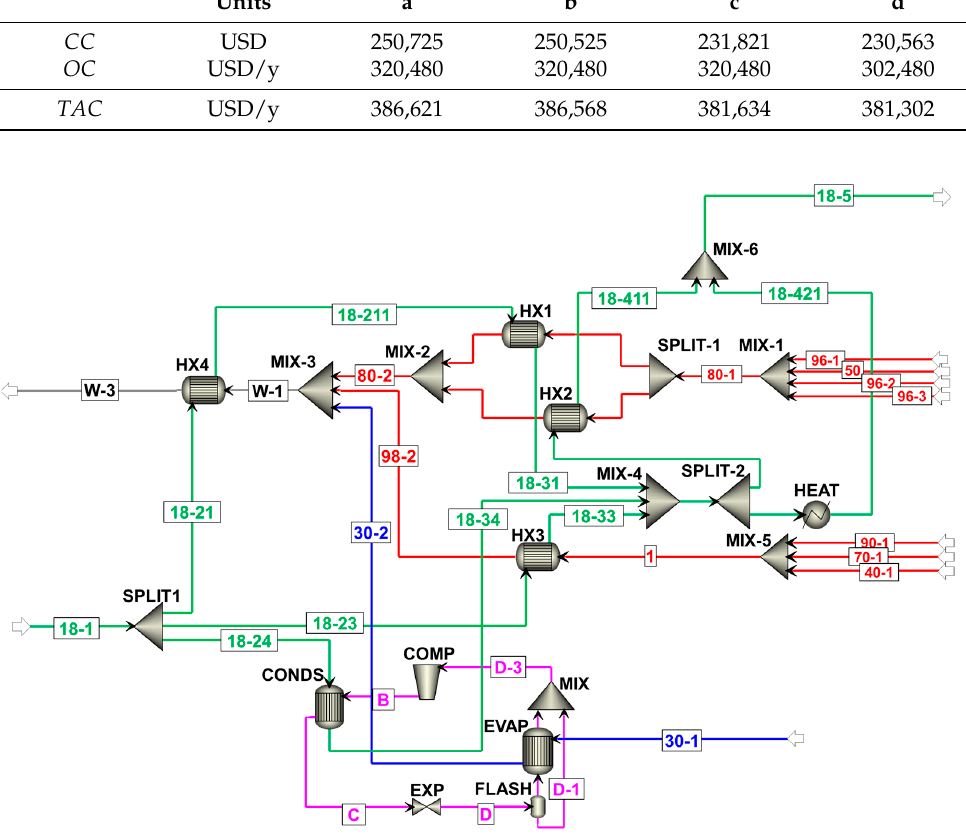
Figure 6. Flow diagram of the final wastewater heat recovery system. Table 6. Specifications of the heat exchanger in the final wastewater heat recovery system.